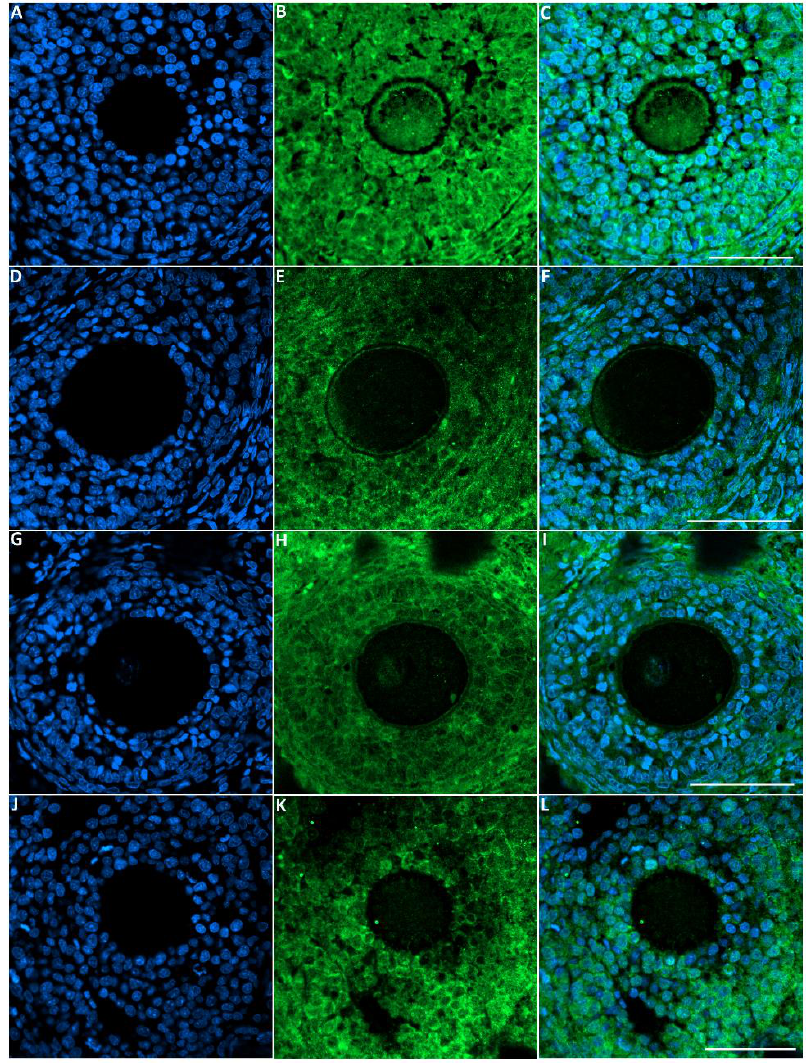
Figure 5. Representative images of GDF-9 immunofluorescence staining in rats of the different groups of the experiment. Control group ( A – C ), 2000 ppm-treated group ( D – F ), 4000 ppm-treated group ( G – I ) and 8000 ppm-treated group ( J – L ). Scale bars = 100 µ m.